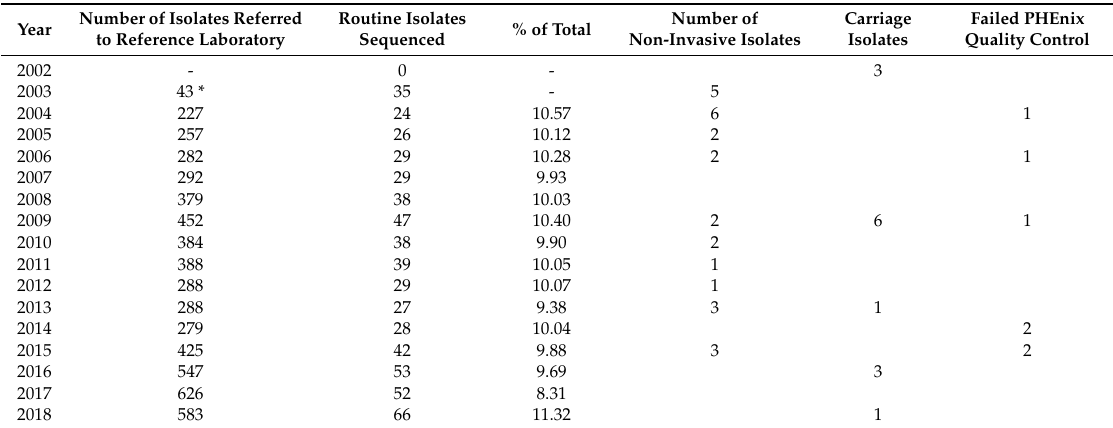
Table 1. Distribution of S. pneumoniae serotype 3 isolates per year including the number of non-invasive isolates from the routine isolates and the number of available carriage